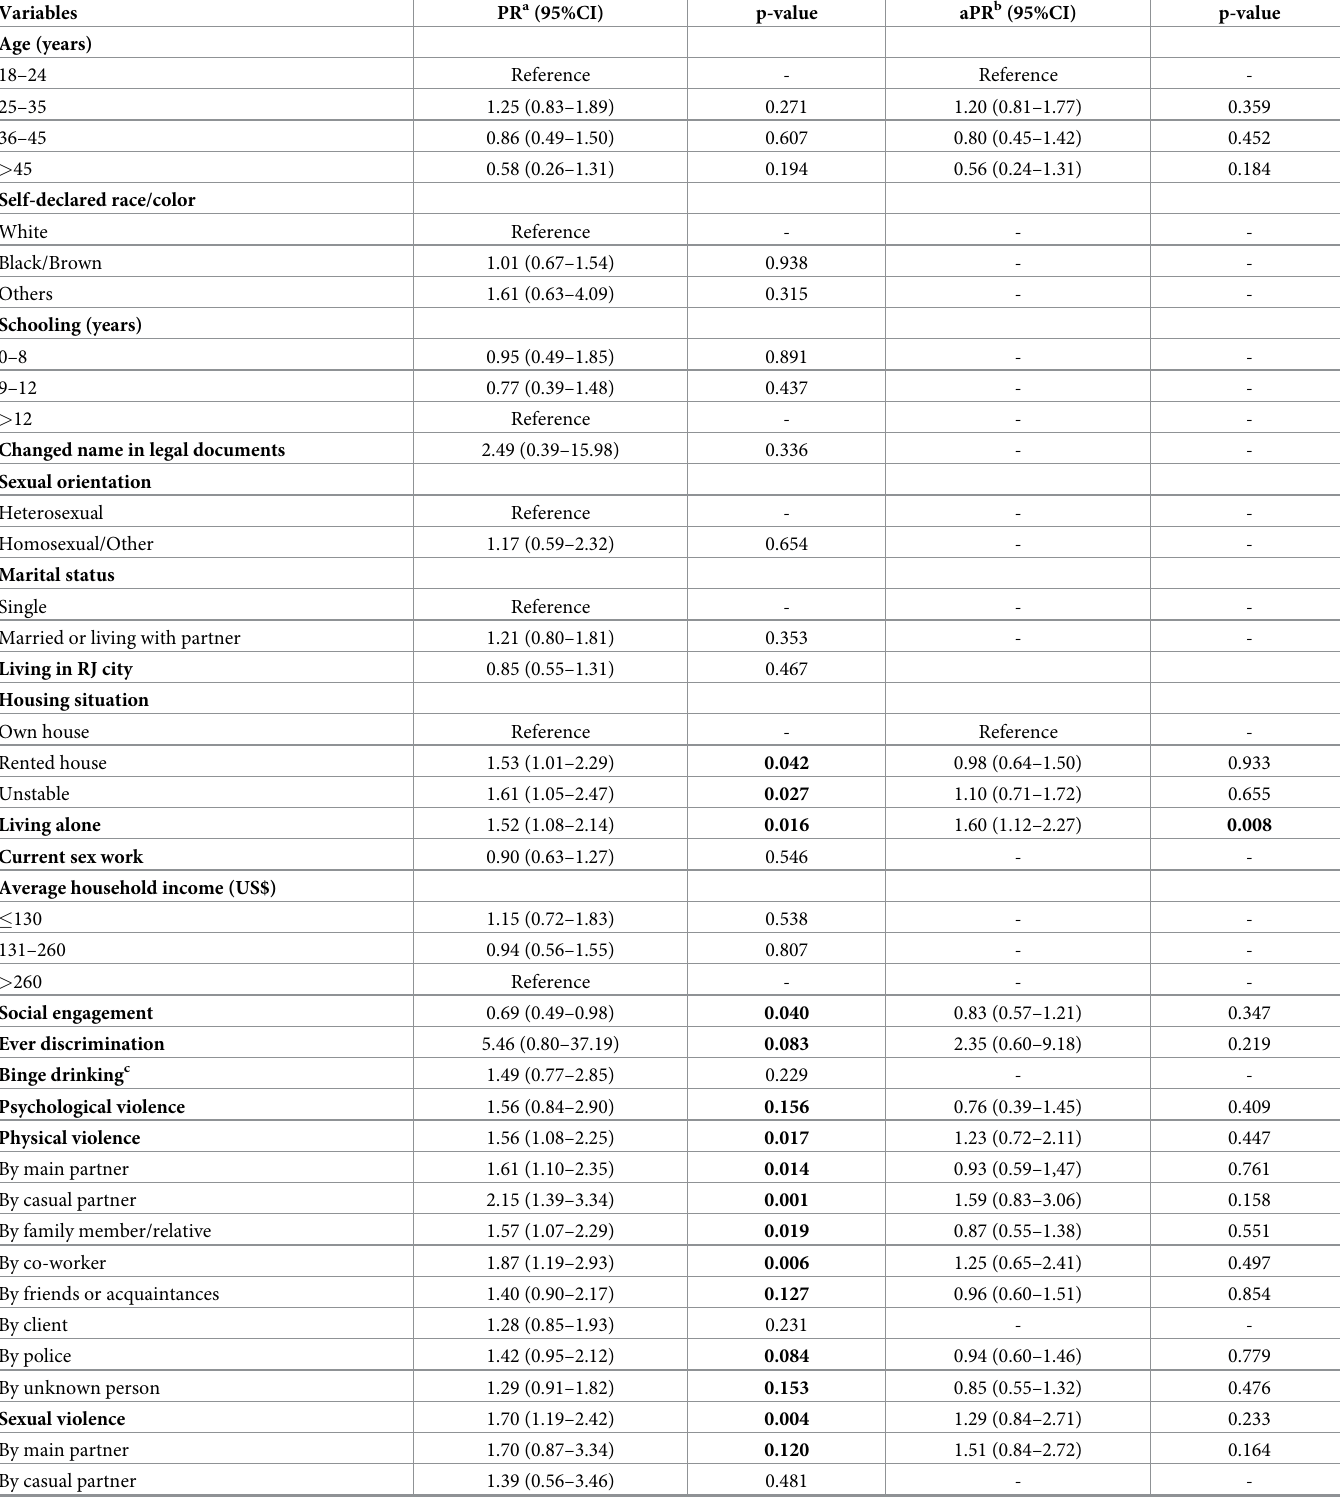
Table 3. Crude and initial model of adjusted prevalence ratio of lifetime attempted suicide among trans women in Rio de Janeiro, Brazil,